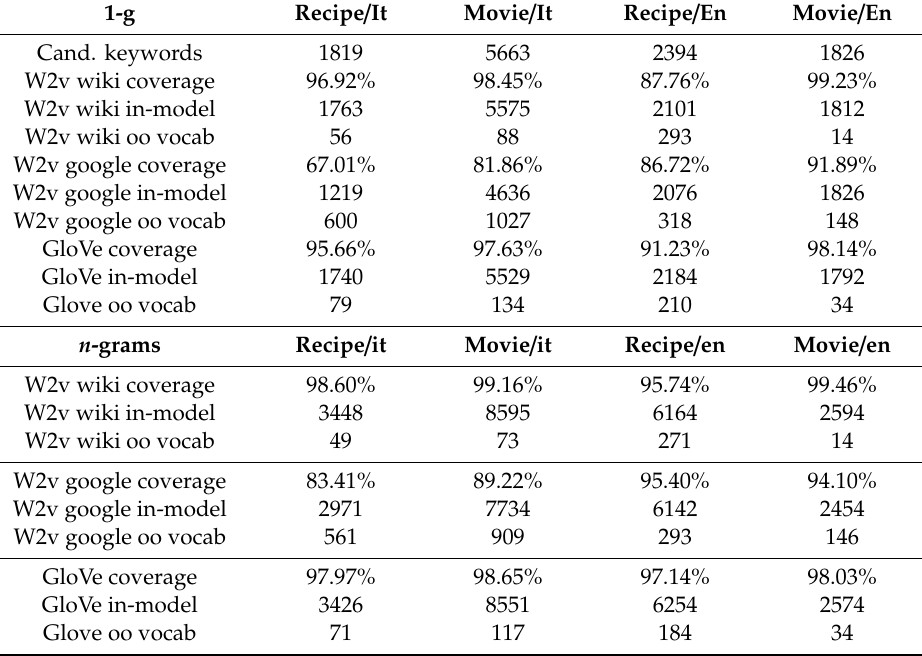
Table A5. Statistics for embedding models on datasets, using 1-g and n